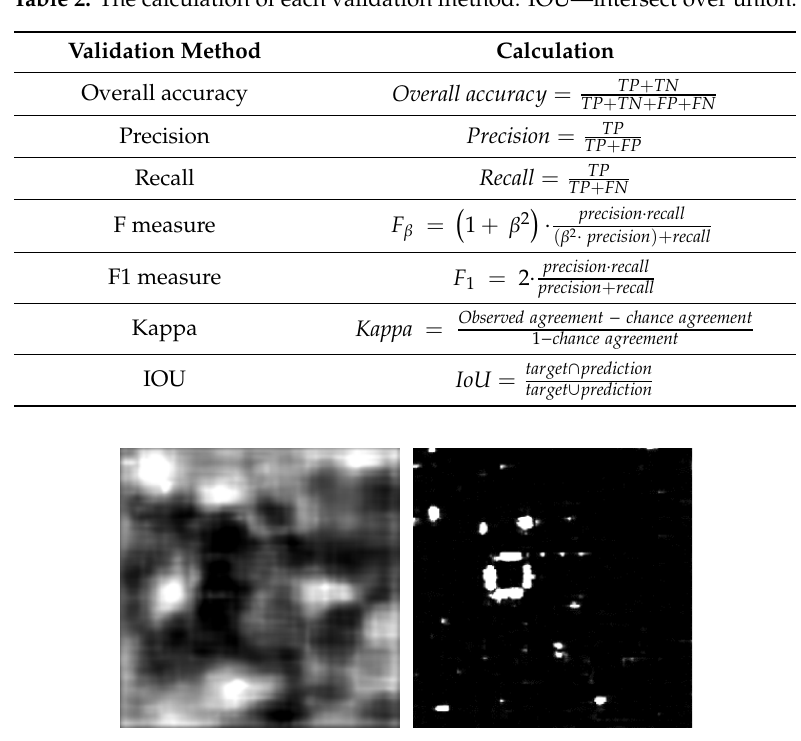
Table 2. The calculation of each validation method. IOU—intersect over union.